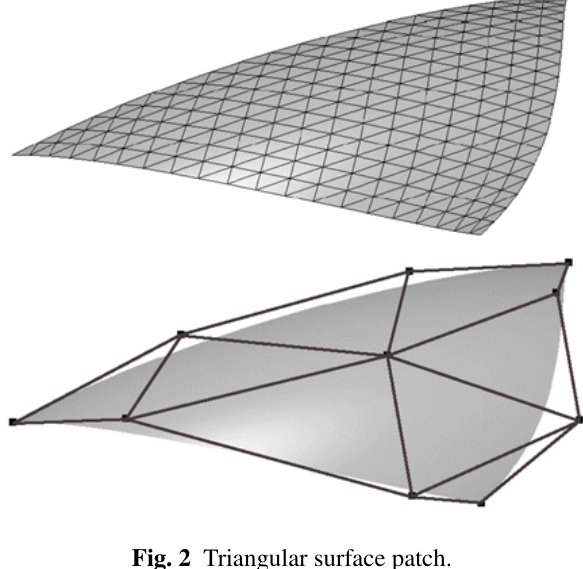
Fig. 2 Triangular surface patch.